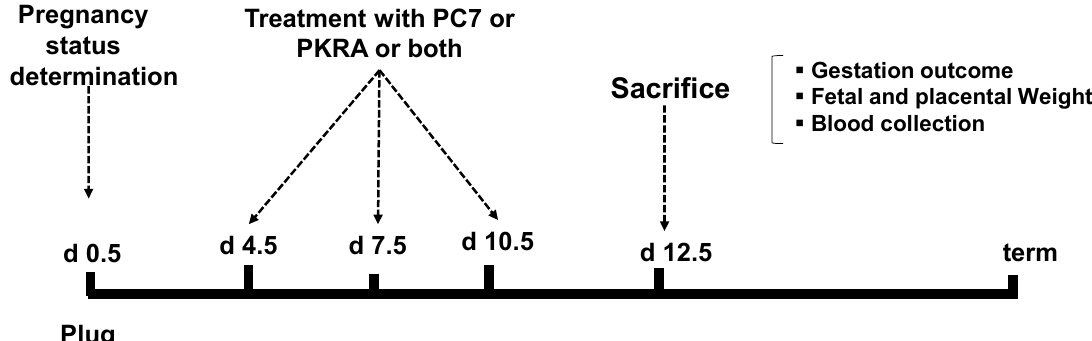
Figure 1. Experimental procedure. The figure illustrates the flow chart of the experimental procedure performed at different time-points during the study. The gravid mice were randomly assigned to be injected with either vehicle, PROKR1 antagonist (PC7) or PROKR2 antagonist (PKRA), or both (PC7+PKRA). The treatment with antagonists started on day 4.5 of gestation and were repeated every 3 days, at 7.5 dpc; 10.5 dpc. Mice were sacrificed at 12.5 dpc.